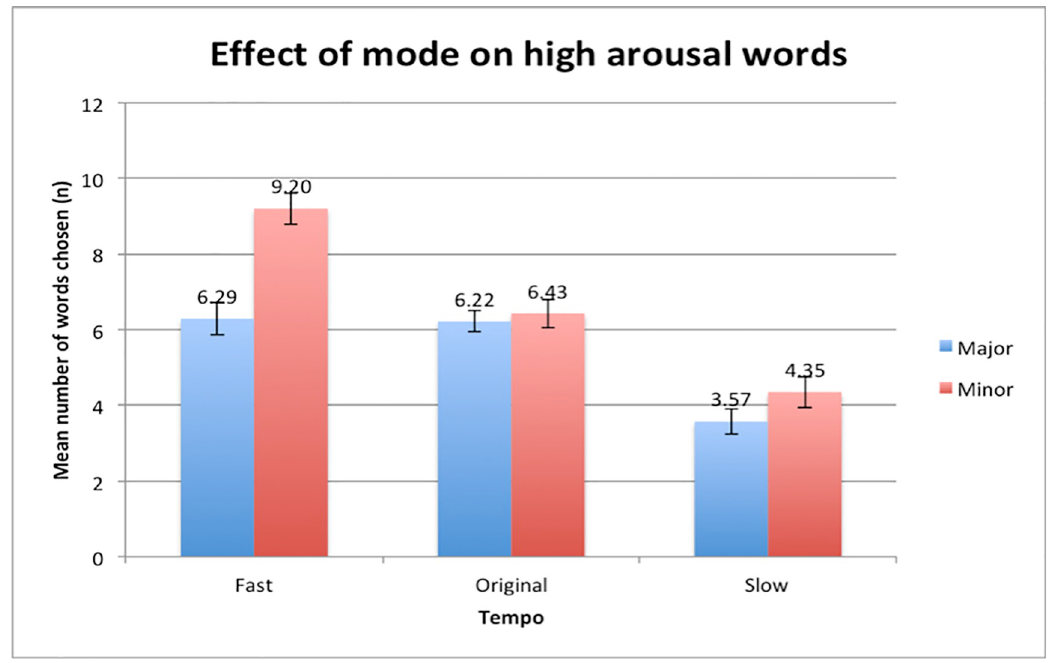
Fig 9. Differences in means of the selection of high arousal words between major and minor mode. Error bars indicate the standard error of the mean.